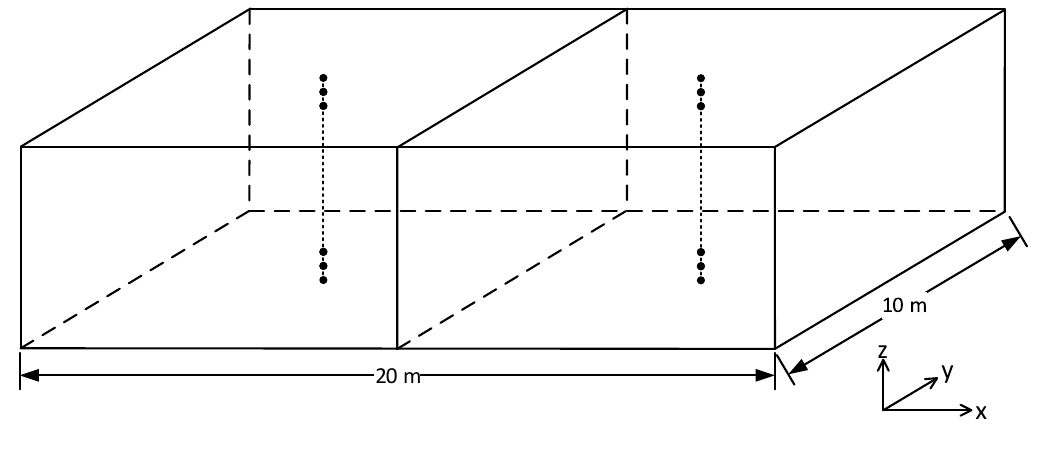
Figure 4. A schematic diagram of the investigated field.